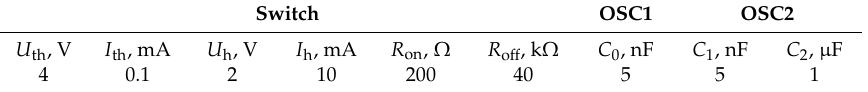
Figure 1. S-type I–V characteristic with unstable NDR segments ( a ), basic oscillator circuits (OSC1) ( b ) and oscillator circuits with a variable resistor R (OSC2) ( c ). Table 1. Parameters of S-Switch and oscillator capacities of OSC1 and OSC2 (Figure 1b,c).